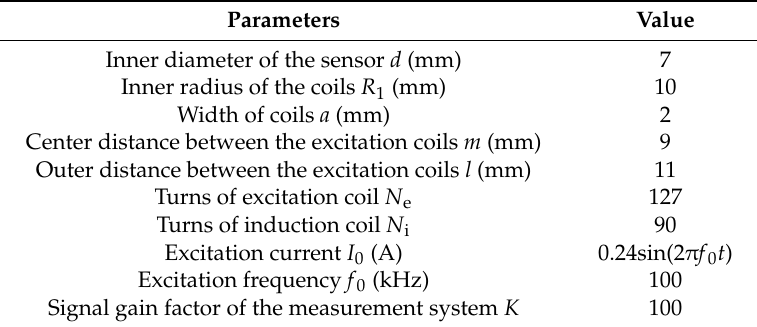
Table 2. The detailed parameters of the experiment system.